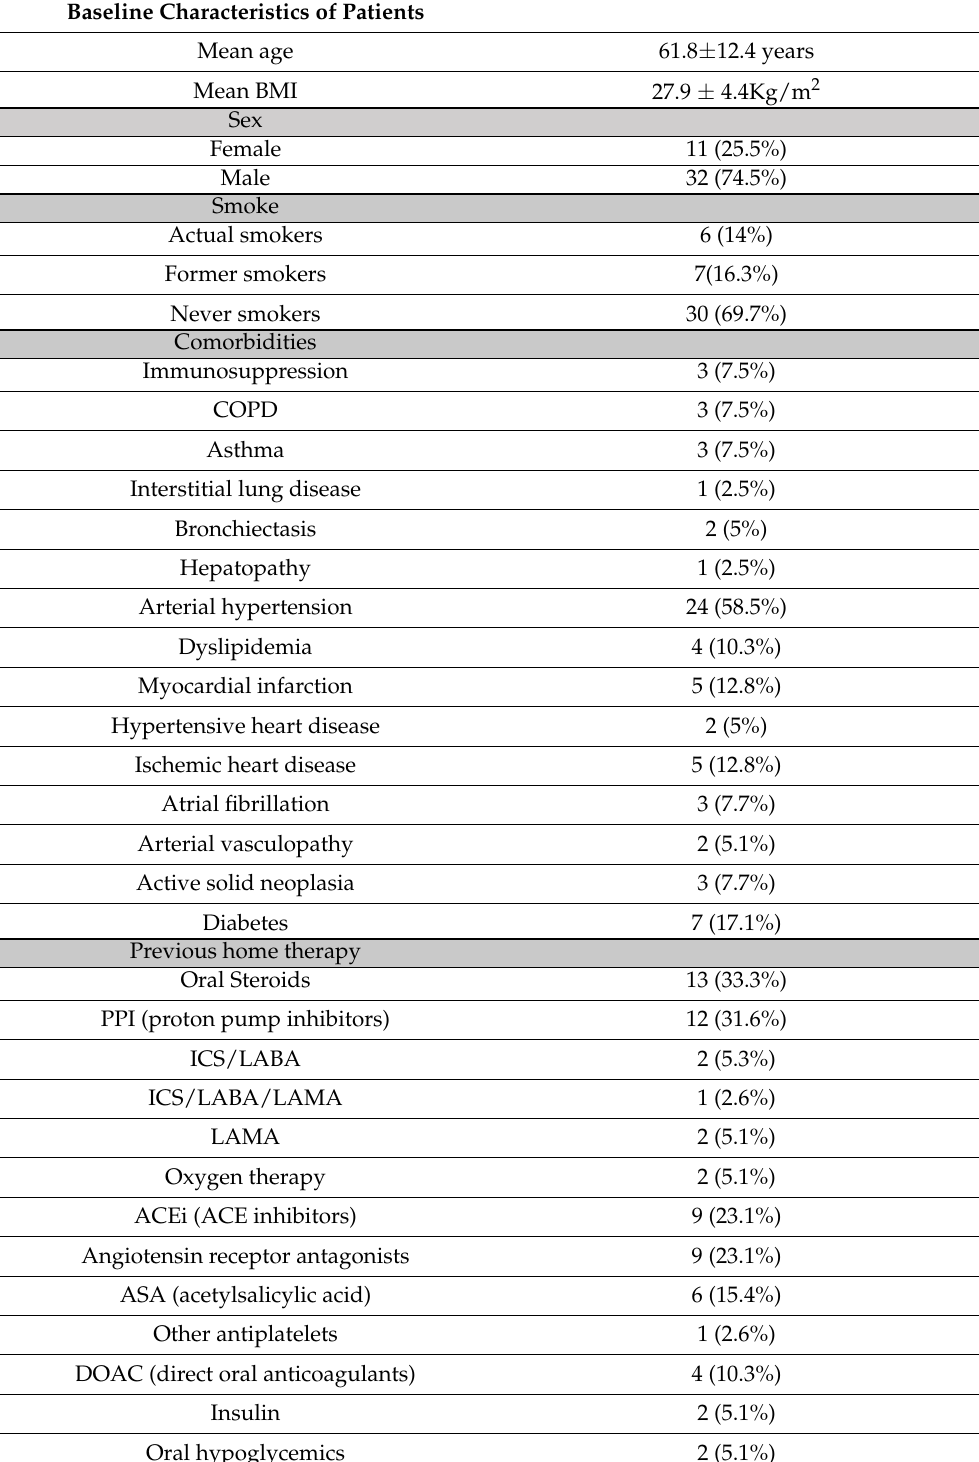
Table 3. Baseline characteristics of the study